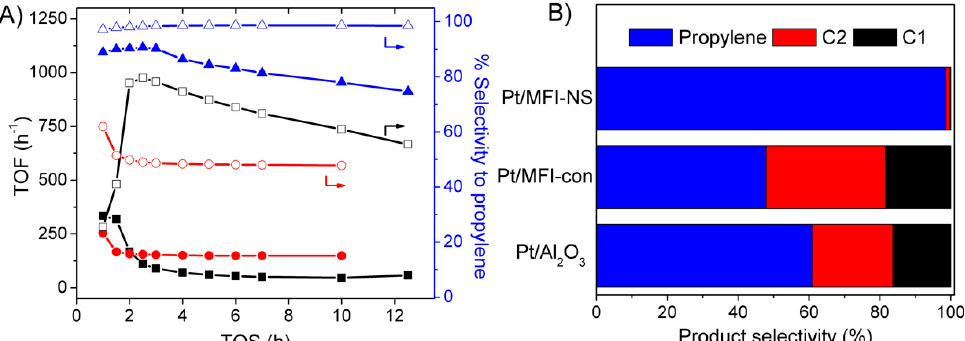
Figure 3. Catalytic performance of propane dehydrogenation over 1 wt.% of Pt supported on different supports, including hierarchical silicalite- 1 nanosheets (Pt/Si-MFI-NS) (blue), conventional silicalite- 1 (Pt/Si-MFI-CON) (red), and aluminum oxide (Pt/Al 2 O 3 ) (black) in terms of ( A ) TOF of propane conversion (solid symbol) and selectivity to propylene (open symbol) as a function of time-on-stream (TOS) and ( B ) Product selectivity at 10 h of TOS obtained at weight hourly space velocity (WHSV) of 2.82 h − 1 .